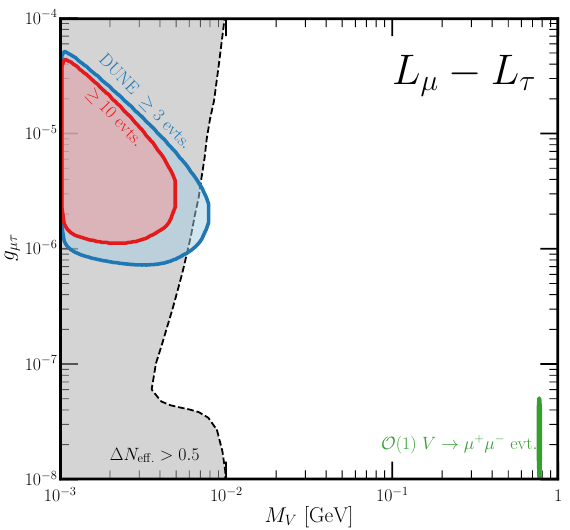
Figure 14 . Expected sensitivity to L (cid:22) L (cid:28) gauge bosons at the DUNE MPD. The region in red (cid:0) (blue) indicates more than ten (three) signal events ( V e + e (cid:0) ) expected. In grey, the region for ! which (cid:1) N e(cid:11) > 0 : 5 at the time of big bang nucleosynthesis [89]. In green is the region of parameter space for which V (cid:22) + (cid:22) (cid:0) may yield (1) signal events, see text for further ! O